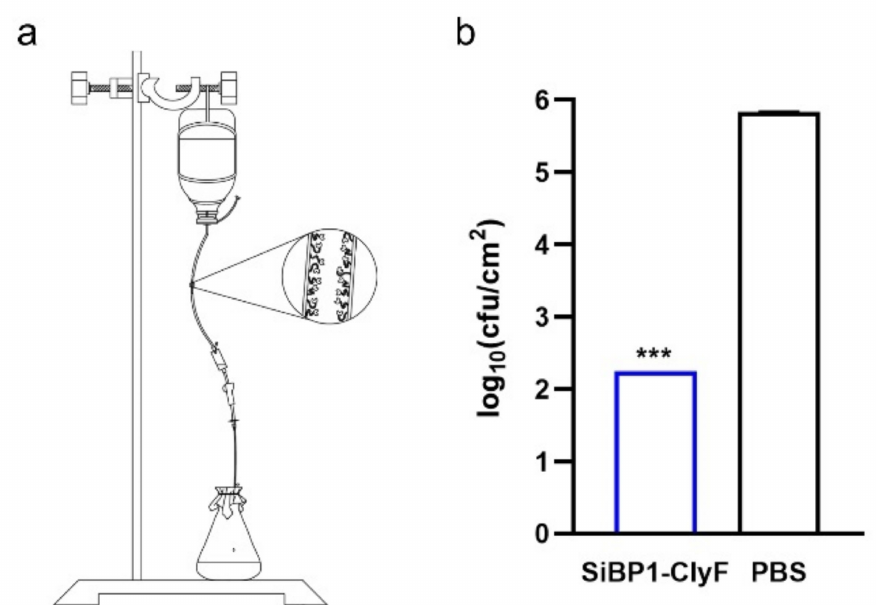
Figure 6. Antibiofouling activity of SiBP1-ClyF-immobilized surfaces against dynamic S. aureus biofilms. ( a ) Schematic diagram of fabricated dynamic S. aureus biofilm model. Silicone